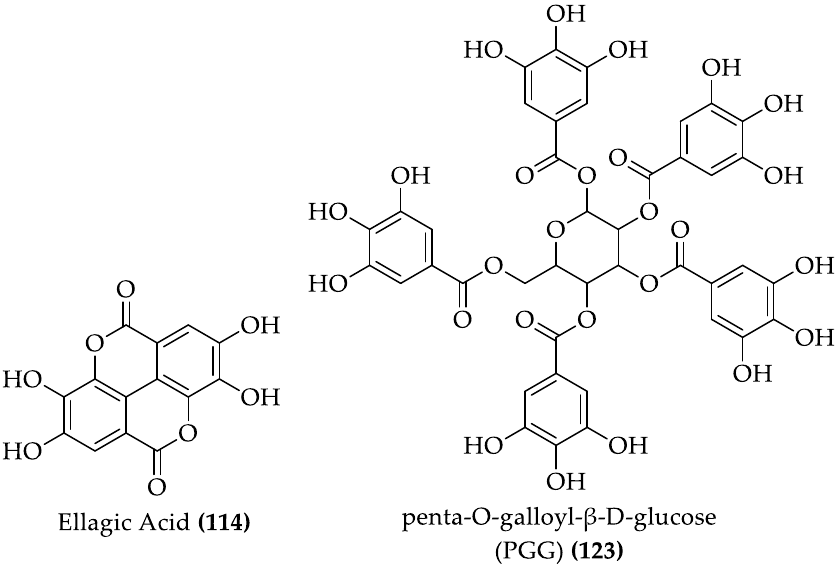
(Figure 21 and Table 15).